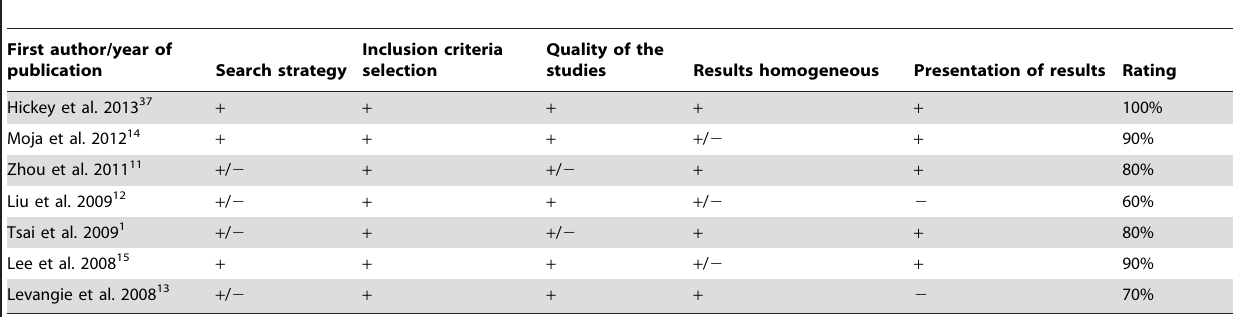
Table 4. Quality test of methodology of the included systematic reviews based on the critical appraisal sheets of the Centre of Evidence Based